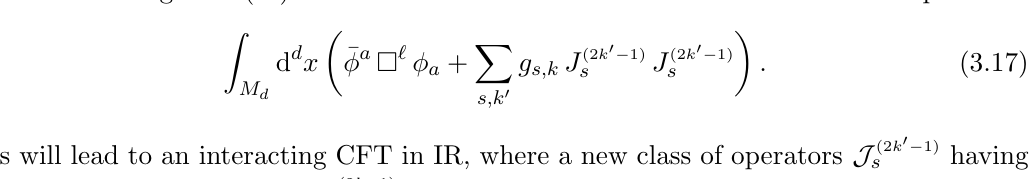
6 ‘ < d , whereas the right one with d . The 4 4 2